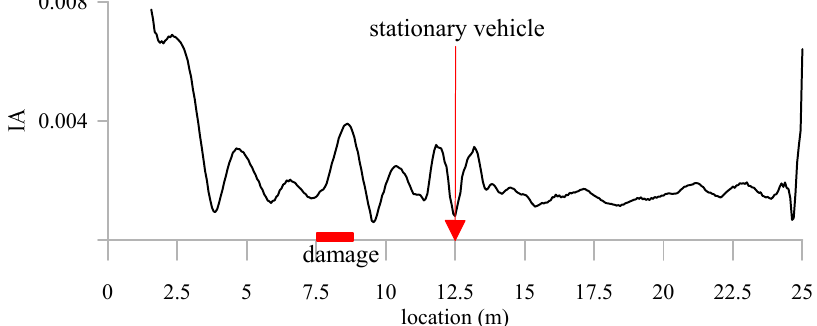
Figure 11. IA of IMF of contact-point response of a stationary vehicle on a bridge with 0.5 m damage size.